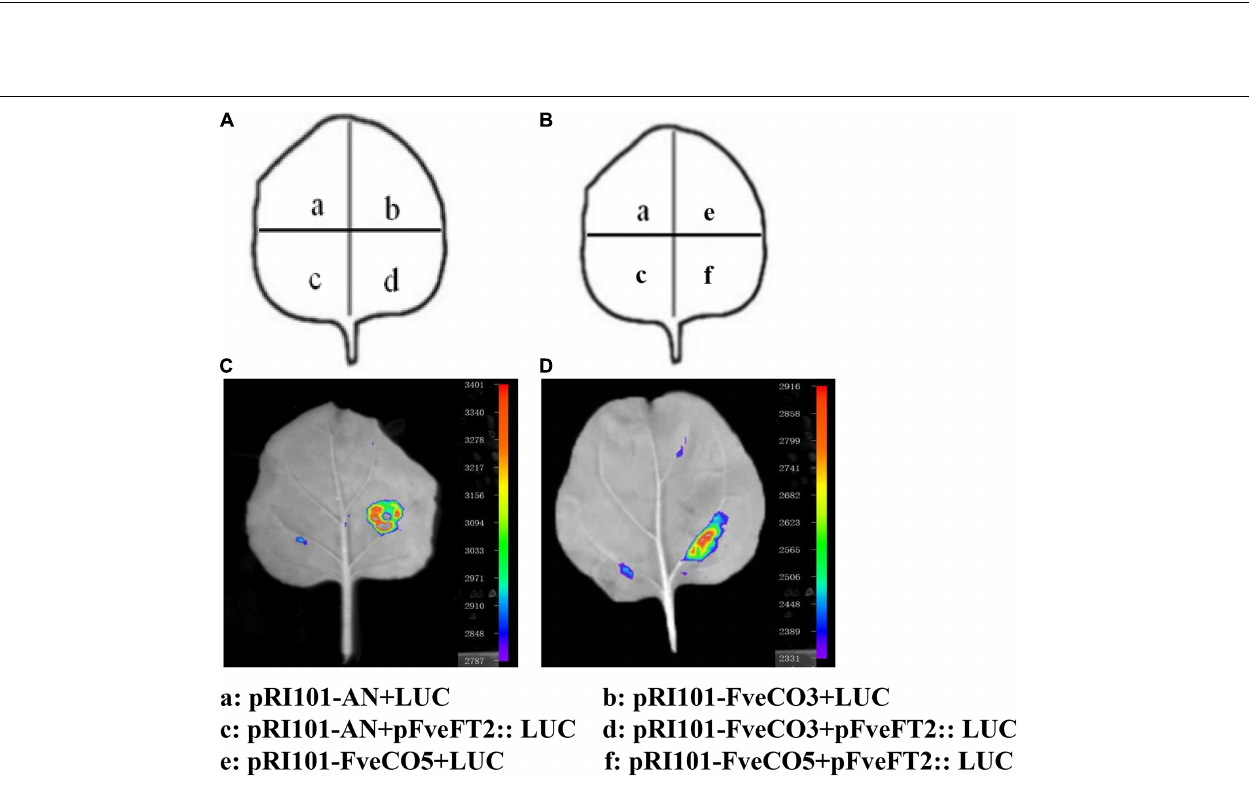
FIGURE 10 | FveCO3 and FveCO5 regulate FveFT1 expression by binding to its promoter. (A,B) Schematic diagram of the reporter and effectors used in luciferase reporter assay. Luciferase reporter assay showing that FveCO3 and FveCO5 regulate FveFT1 expression (C,D) , respectively. The FveCO3 and FveCO5 effector and the proFveFT1 reporter were coinfiltrated into tobacco leaves, and the luciferase signal was measured.